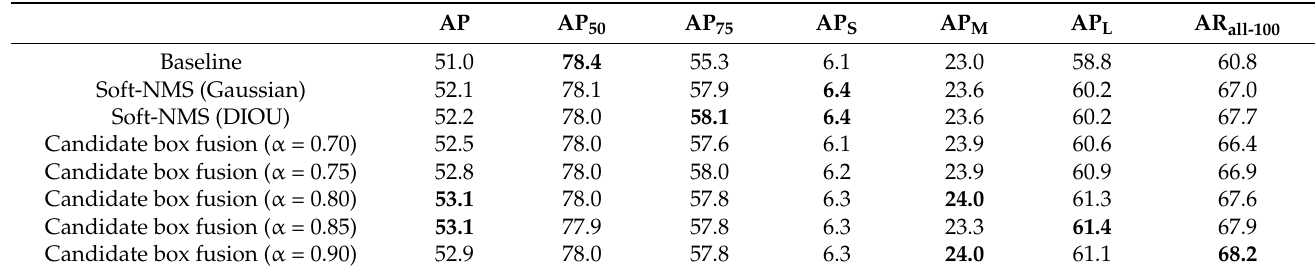
Table 1. The influence of different α on Soft-DIOU-NMS with weighted box fusion.